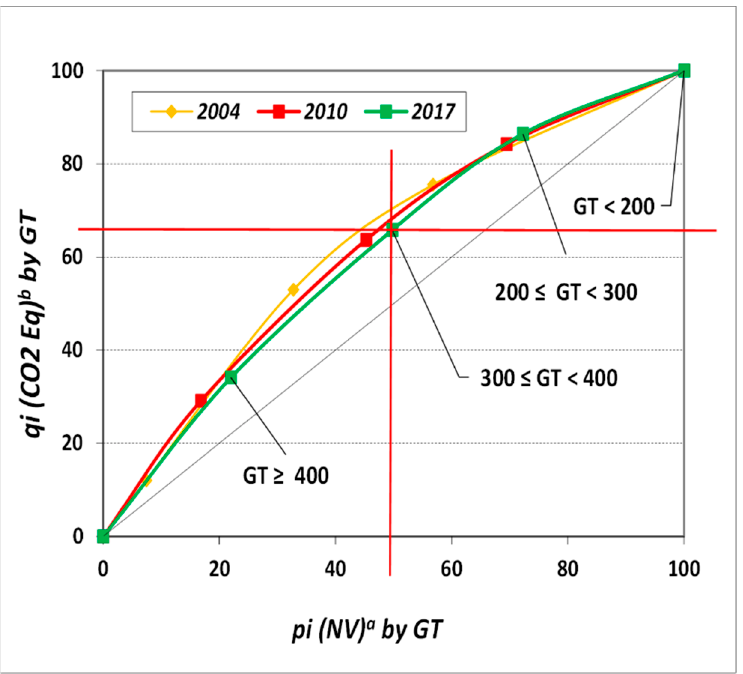
Figure 10. Lorenz curves of greenhouse gas emissions of the Spanish tugboat fleet by size (GT). Source: authors. a = accumulated percentage of tugboats by GT; b =accumulated percentage of emissions of CO 2 equivalent by GT.